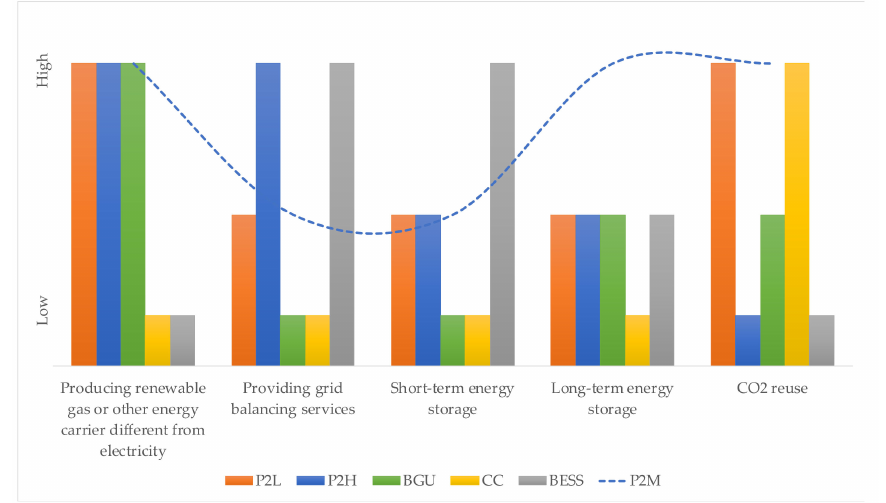
Figure 6. P2M attribute package as a new value curve (relative